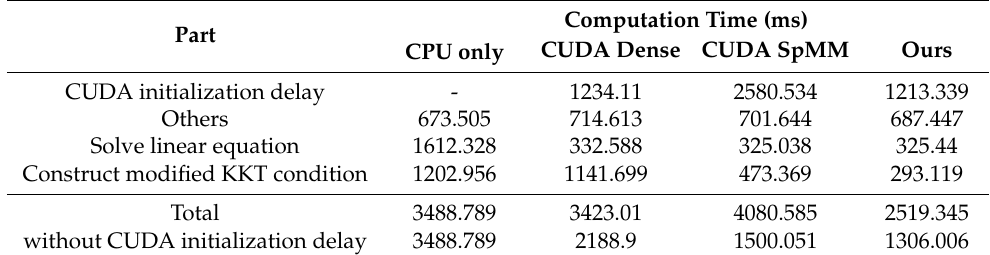
Table 6. The computation time comparison results of the entire